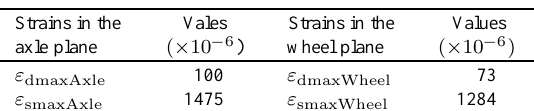
Table 4 The maximum strains of the piston rod Strains in